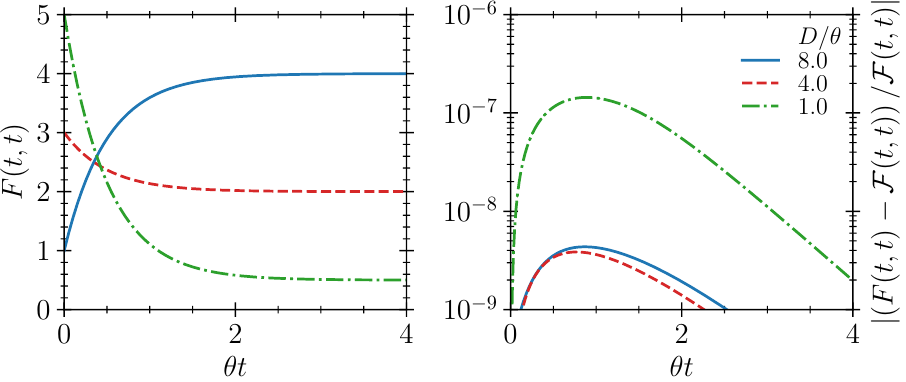
Figure 16: Numerical solution and relative error of Eqs. (85) with rtol = 1e-7 and atol = 1e-9